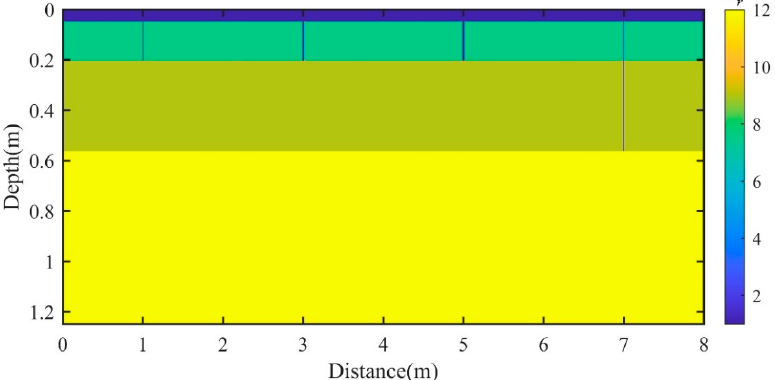
Figure 6. Model 7, a2 D layered homogenous model with three fatigue cracks and a reflective crack.